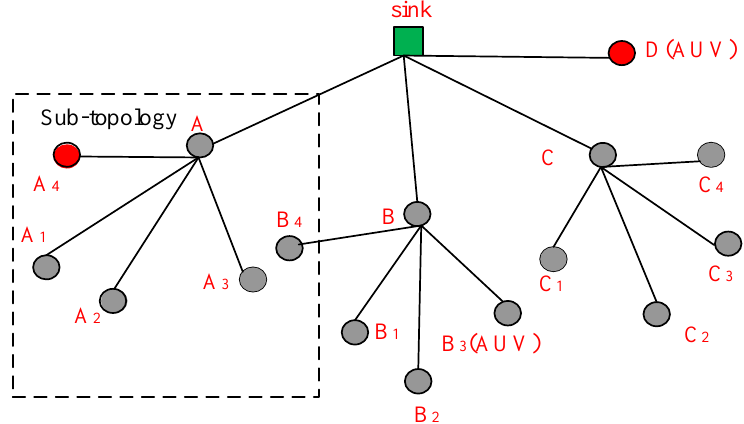
Figure 10. Network topology used in simulations.